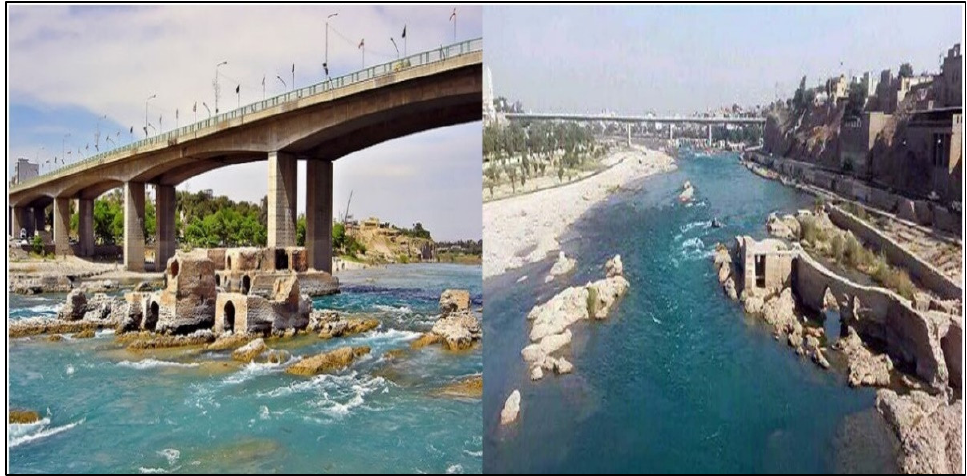
Figure 7. Remnants of the Dezful water mills on the bed of the Dez river in southwest Iran.